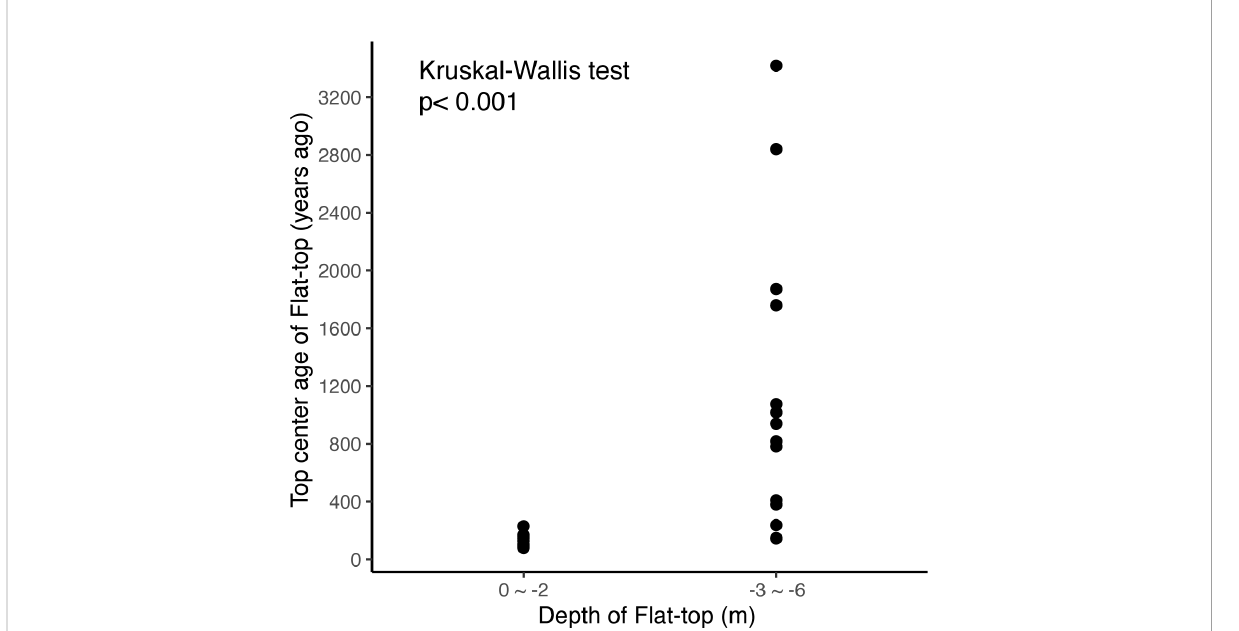
FIGURE 5 Comparison of the ages of the centers of surfaces of fl at-top patch reefs with different depths. The 24 core samples collected from the centers of the surfaces of the fl at-top patch reefs (F1 – F24) were divided into two groups: 0 to − 2 m ( n = 9) and − 3 to − 6 m ( n = 15). A nonparametric Kruskal – Wallis test revealed a signi fi cant difference in center age between the two groups.